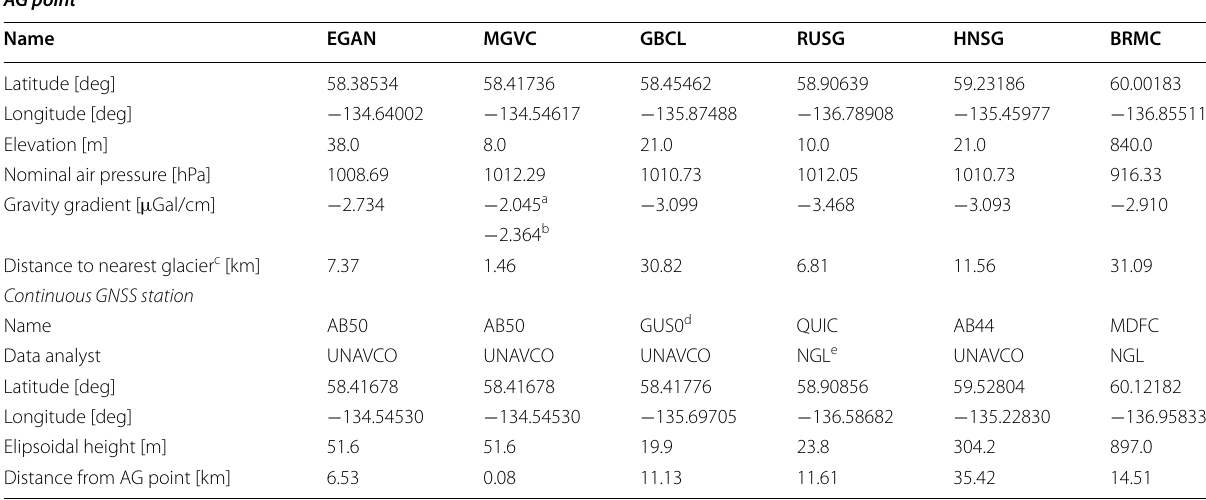
Table 1 Parameters of AG points (Sun et al., 2010) and their nearest GNSS